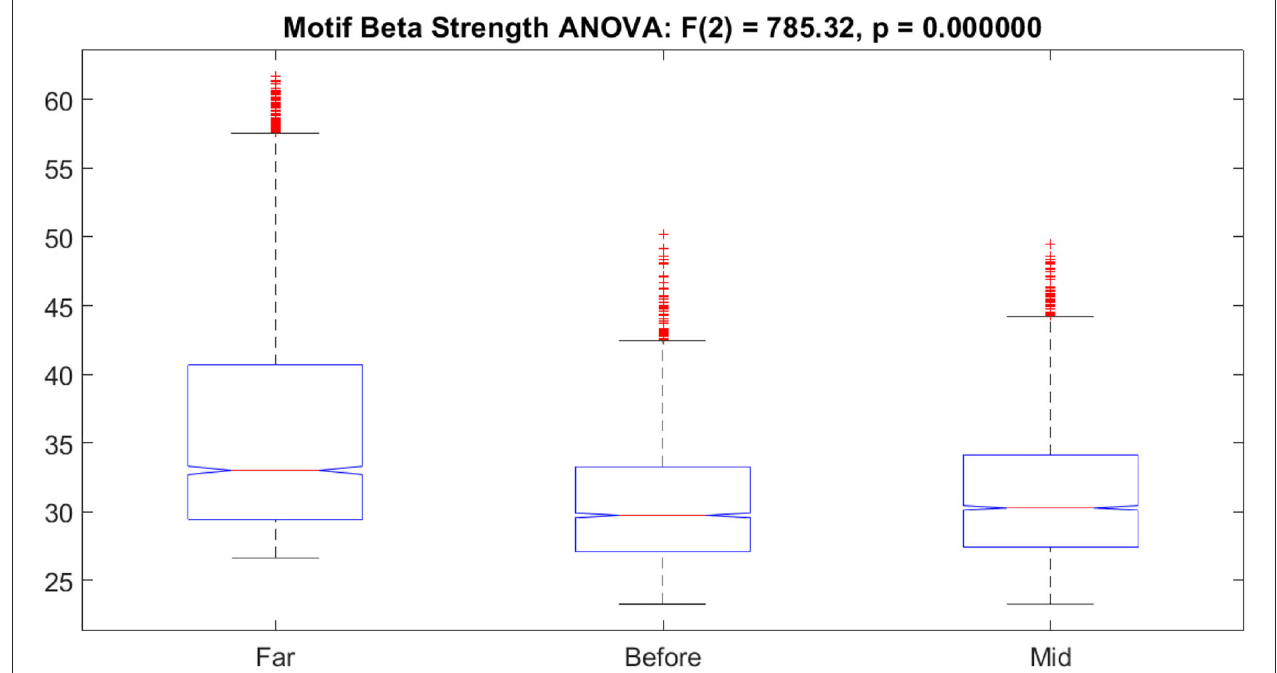
FIGURE 7 | Boxplot for global strength obtained with the motif method applied to the beta band and corresponding ANOVA result, comparing distributions obtained from far, before, and mid 1s EEG segments.